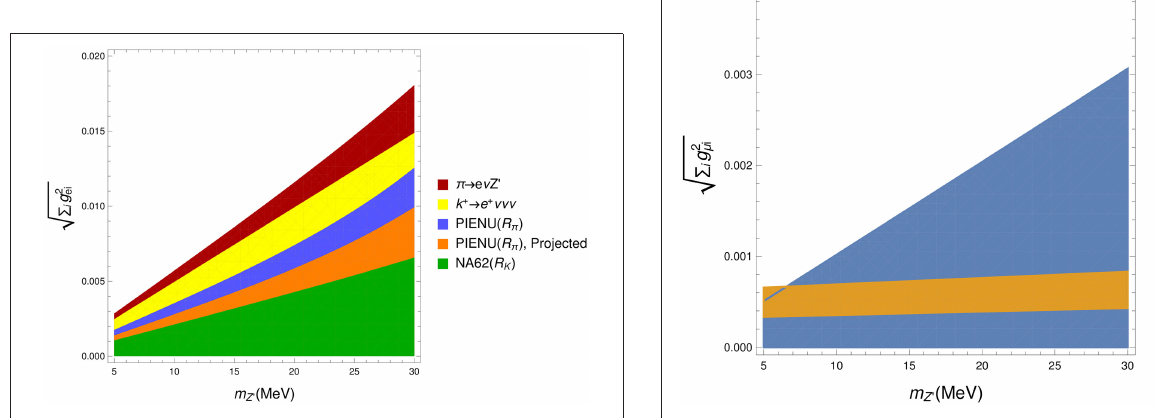
FIGURE 11 | 90 % C.L. constraints on